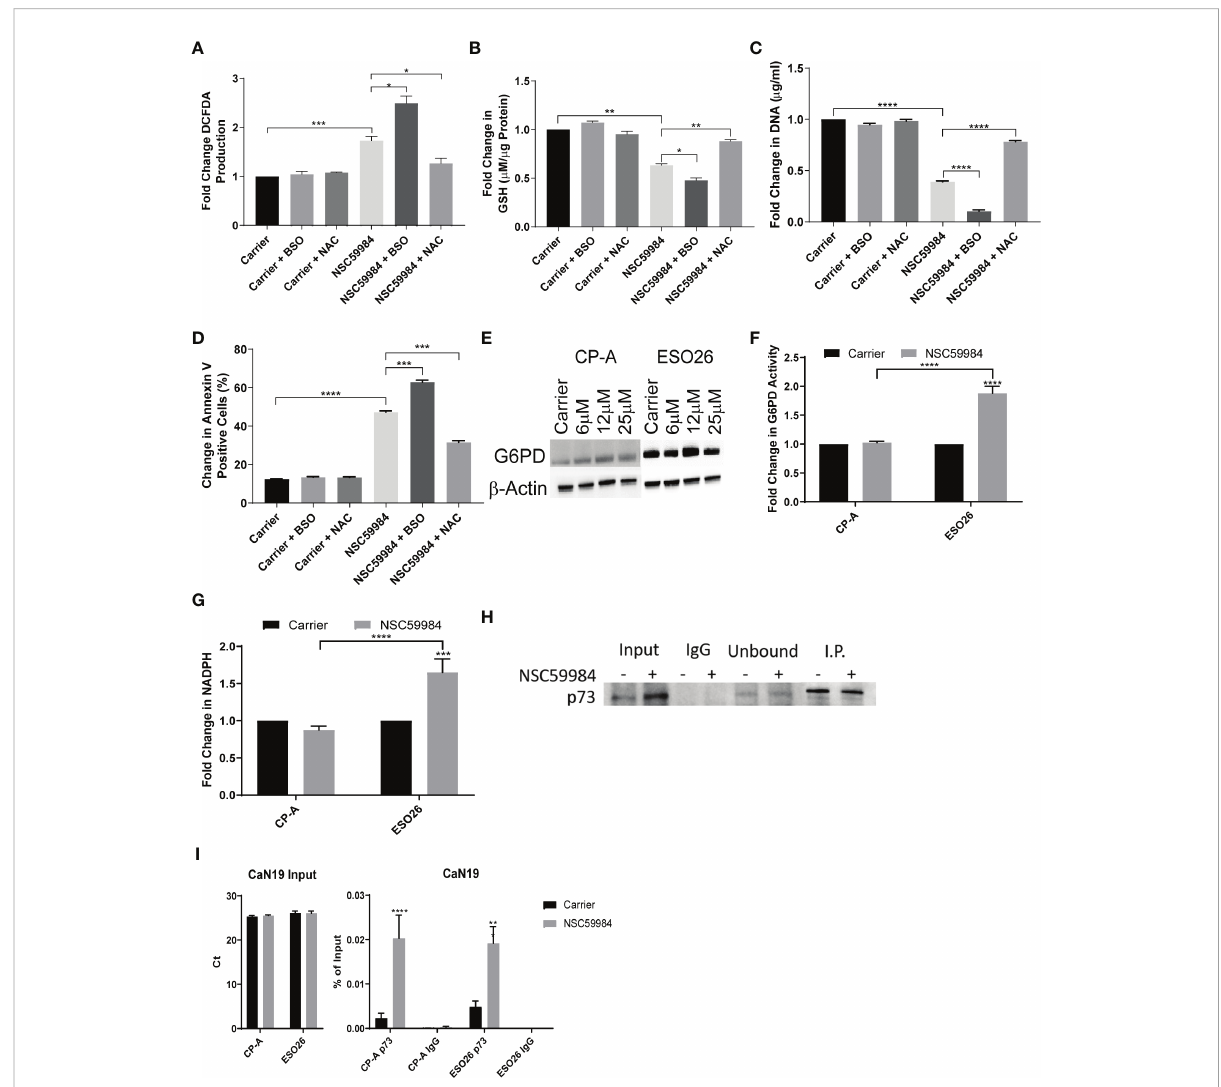
FIGURE 5 Modulation of NSC59984 effects by combination treatment with ROS regulators. (A) Fold change in total ROS levels (DCFDA) following treatment of ESO26-R248W cells with NSC59984 (12 m M) for 24 hr either alone or in combination with NAC (1 mM) or BSO (10 mM) over carrier control. Fold change in carrier-treated cells was normalized to 1 (B) Fold change in total GSH level (µM GSH per µg of cellular protein) in ESO26-R248W cells treated with NSC59984 (12 m M) for 24 hr either alone or in combination with NAC (1 mM) or BSO (10 mM) over carrier control. Fold change in carrier-treated cells was normalized to 1. (C) . ESO26-R248W cellular proliferation was measured following treatment with NSC59984 (12 m M) for 24 hr either alone or in combination with NAC (1 mM) or BSO (10 mM). Cells were re-seeded and fold change